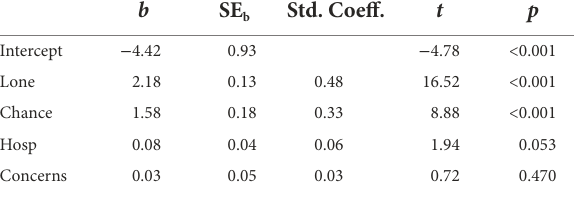
TABLE 8 Multiple regression analysis of the contributions of pandemic-associated concerns to psychological distress (HADS). b SE b Std. Coeff.